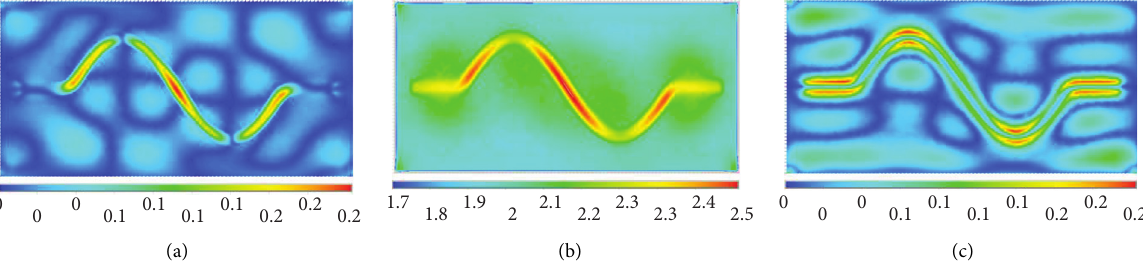
� 500m/s, and NR � 2). Top view displacement cloud view (a) u s